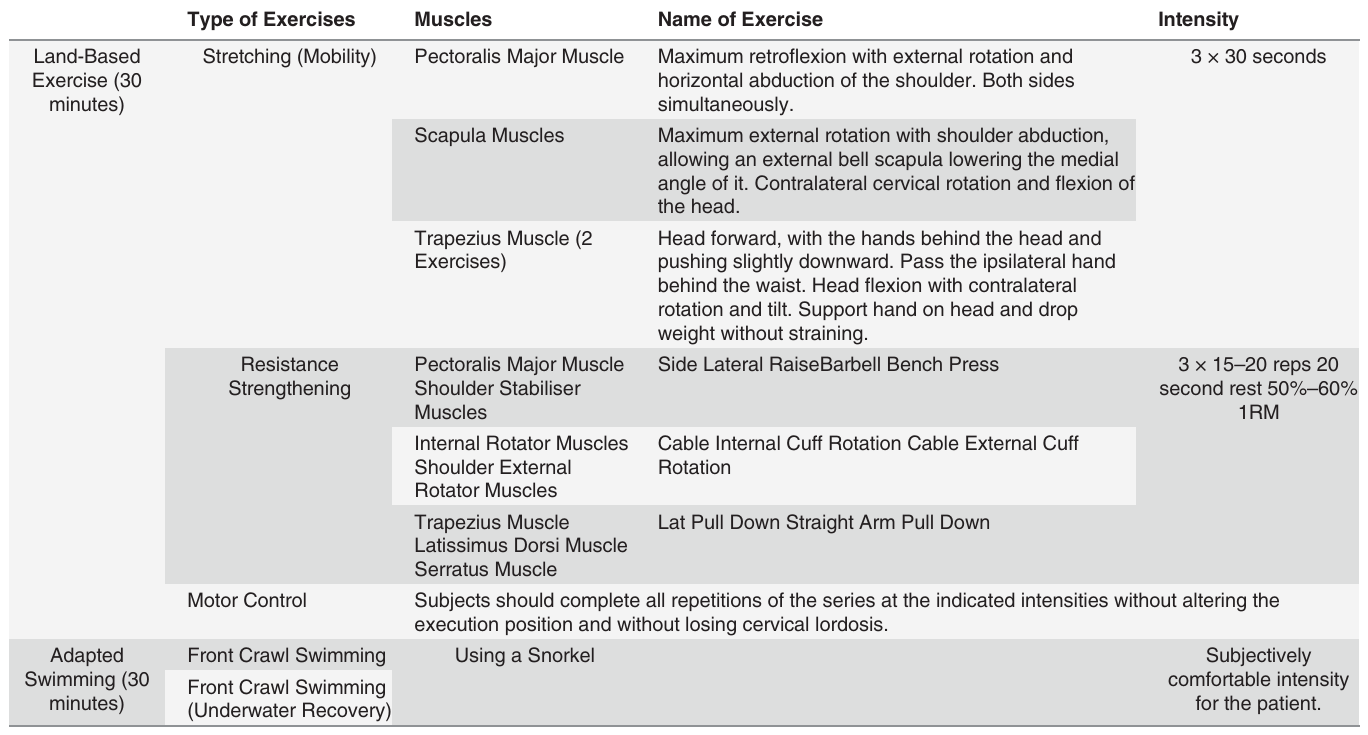
Table 1. Scheme of the performed land-based and adapted swimming exercises and their intensity. Type of Exercises Muscles Name of Exercise Intensity Land-Based Stretching (Mobility) Exercise (30 minutes)